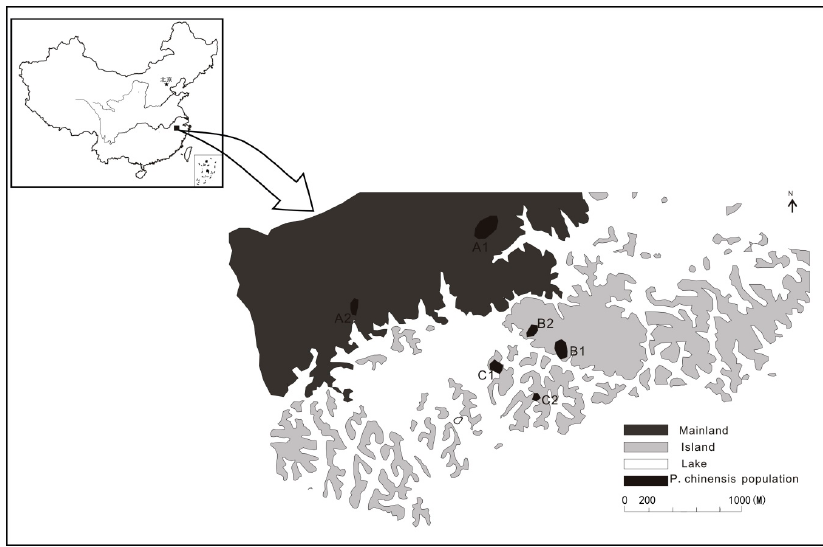
Figure 2. Map indicating the locations of the six Pistacia chinensis populations. Large island habitats B1 and B2; and small island habitats C1 and C2.